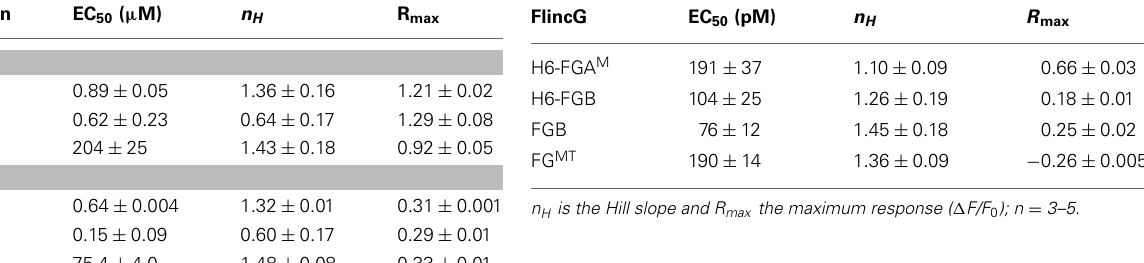
contributing to panel D . NO concentrations (specified at bottom) were superfused for the time indicated by the horizontal bars. Traces are means of 11–24 cells; the calibration (top left) applies to all of them. The inset illustrates the heterogeneity in the response profile amongst cells in a given experiment often (but not always) observed at the higher NO concentrations. Also at the higher concentrations, responses were sometimes followed by small, rapid undershoots and small, slow secondary fluorescence increases (or decreases in the case of FG MT , bottom trace), as was observed previously with adenoviral FlincG-infected HEK GC / PDE5 cells (Batchelor et al., 2010).